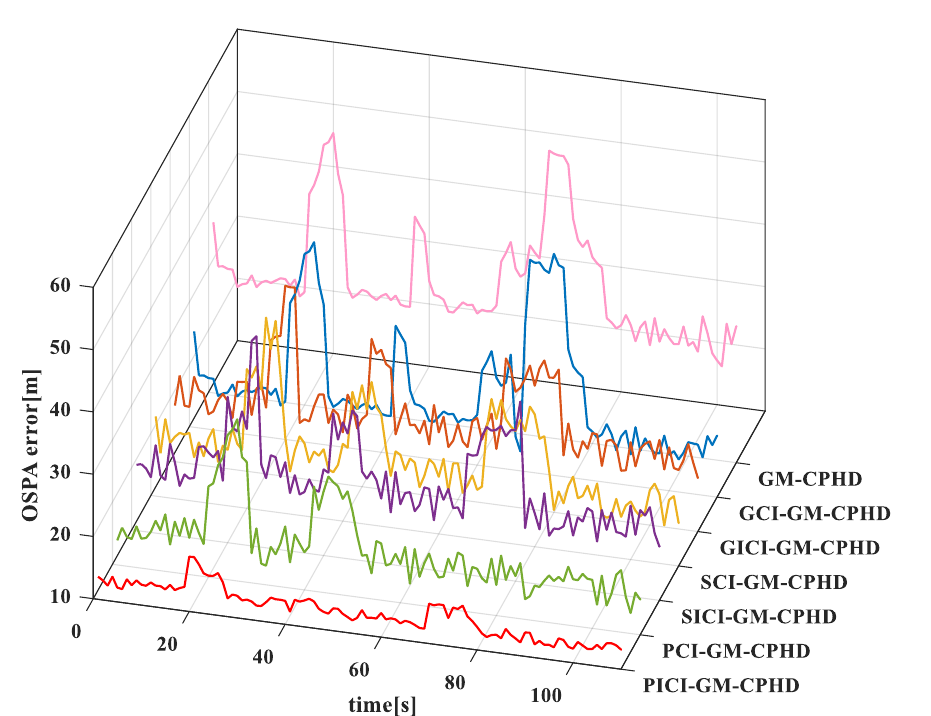
Figure 11. Comparison of OSPA distance errors of several algorithms in nonlinear models.